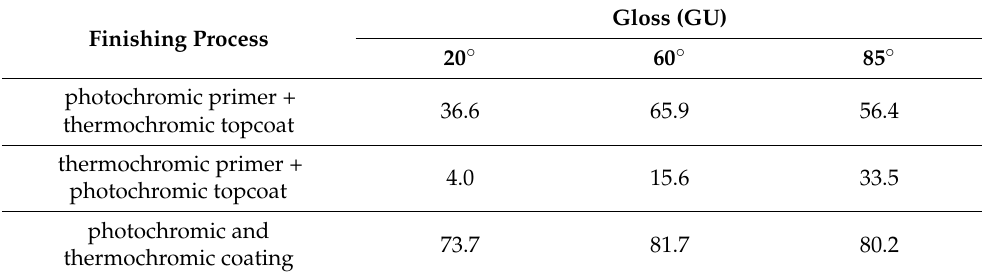
Table 4. The gloss of the film under different finishing sequences.